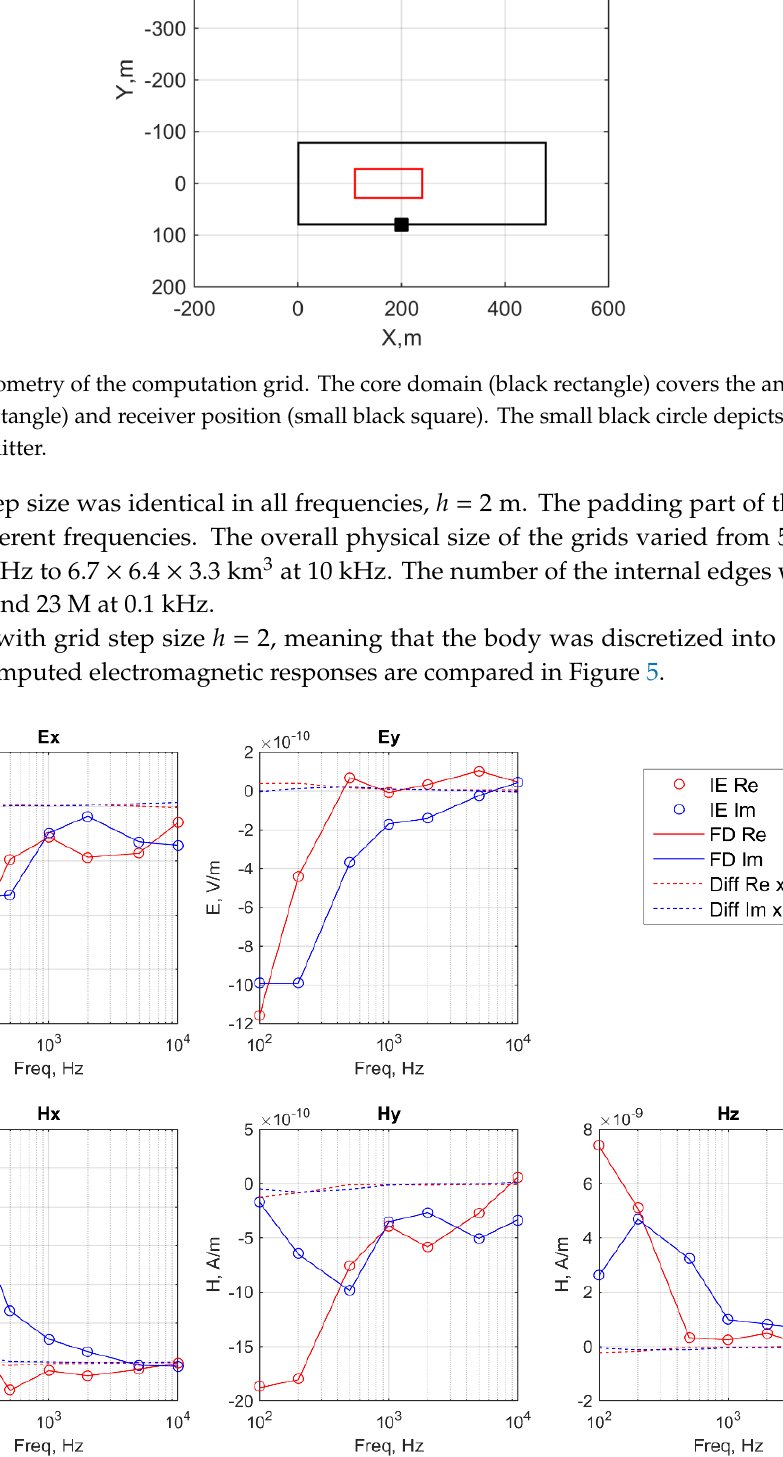
Figure 5. Benchmark against PIE3D software. “IE” and “FD” mean the integral-equation software (PIE3D) and the finite-difference software (our code), respectively. “Re” and “Im” mean the real and imaginary parts, respectively. Note that the difference curves are magnified by factor 10.